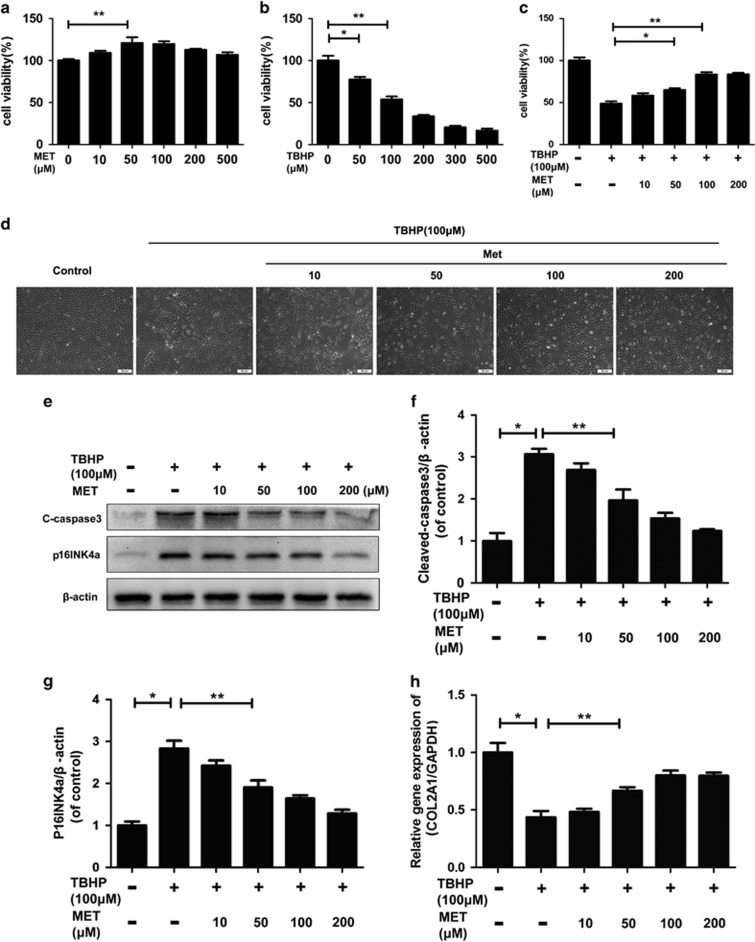
Metformin treatment inhibits TBHP-induced nucleus pulposus cell apoptosis and senescence. (a) Cell Counting Kit-8 (CCK-8) results of nucleus pulposus cells treated with different concentrations of metformin for 24 h. (b) CCK-8 results of nucleus pulposus cells treated with different concentrations of TBHP for 4 h. (c) CCK-8 results of metformin-pretreated nucleus pulposus cells induced by TBHP. (d) Nucleus pulposus cells were pretreated with metformin and then TBHP and imaged by phase-contrast microscopy (original magnification × 100, scale bar: 50 μm). (e–g) Protein content of cleaved caspase3, p16INK4a of nucleus pulposus cells treated with TBHP and TBHP plus metformin. (h) The mRNA expression of Col2a1 of nucleus pulposus cells treated with TBHP and TBHP plus metformin was measured by real-time PCR. The data in the figures represent the averages±S.D. Significant differences between the treatment and control groups are indicated as **P<0.01,*P<0.05, n=3